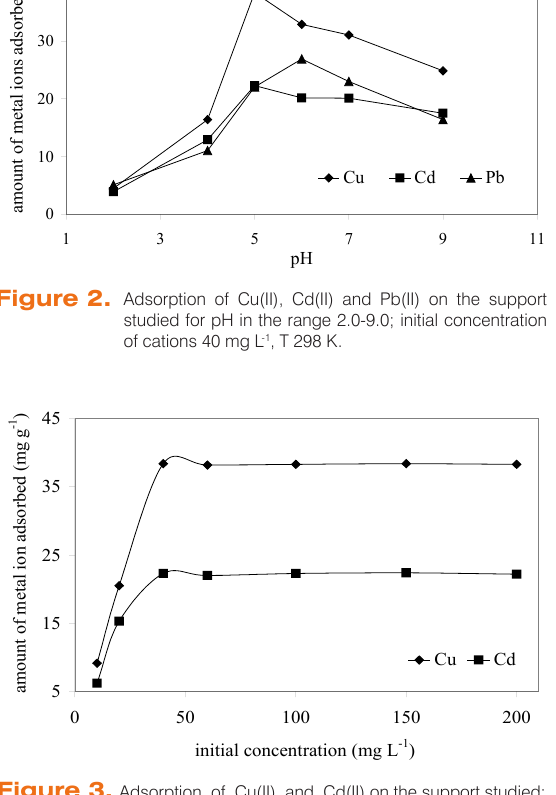
Figure 3. Adsorption of Cu(II) and Cd(II) on the support studied; pH 5.0, T 298 K.